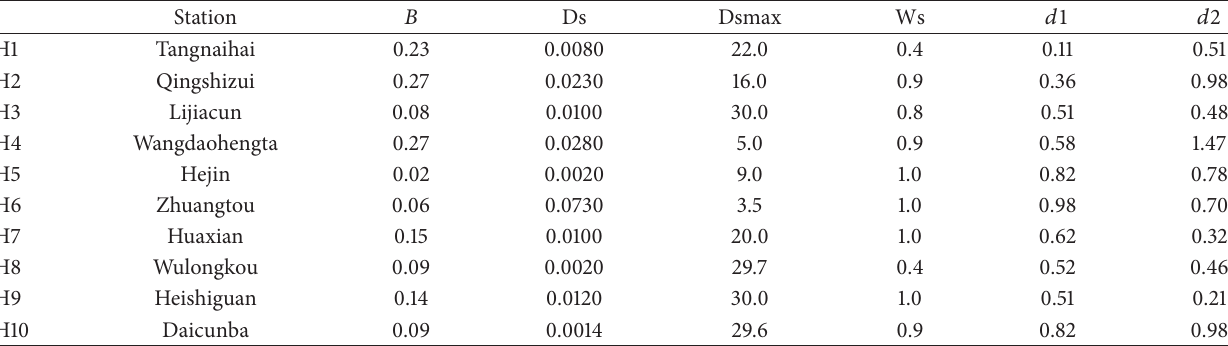
Table 2: Values of six calibrated hydrological parameters.